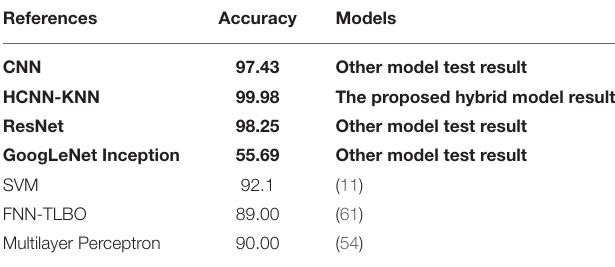
TABLE 7 | Comparison between the proposed HCNN-KNN model and other studies in bam based on dental CNN HCNN-KNN